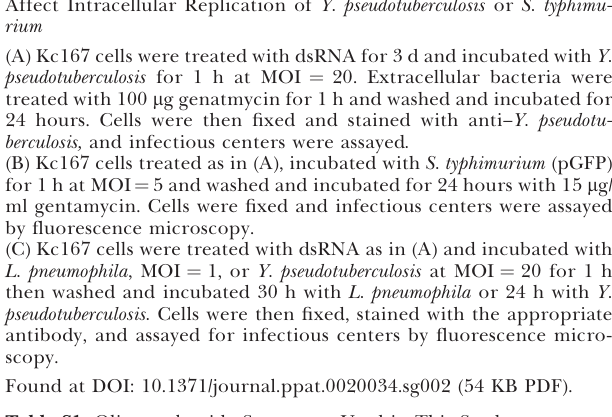
Figure S1. L. pneumophila Replicates Normally in Drosophila Kc167 Cells Kc167 cells were plated in 24-well dishes and incubated with Lp02 (intact type IV translocation system) or Lp03 ( dotA (cid:1) , defective for type IV translocation) at MOI ¼ 0.1 for 1 h; the monolayers were then washed and lysed, and bacterial counts were titred for colony- forming units at the indicated times. Each well was plated in duplicate and each timepoint represents triplicate wells. The mean is shown, 6 standard error. Figure S2. RNAi Directed against Cdc48/p97 and Cofactors Does Not Affect Intracellular Replication of Y. pseudotuberculosis or S. typhimu- rium (A) Kc167 cells were treated with dsRNA for 3 d and incubated with Y. pseudotuberculosis for 1 h at MOI ¼ 20. Extracellular bacteria were treated with 100 l g genatmycin for 1 h and washed and incubated for 24 hours. Cells were then fixed and stained with anti –Y. pseudotu- berculosis, and infectious centers were assayed . (B) Kc167 cells treated as in (A), incubated with S. typhimurium (pGFP) for 1 h at MOI ¼ 5 and washed and incubated for 24 hours with 15 l g/ ml gentamycin. Cells were fixed and infectious centers were assayed by fluorescence microscopy. (C) Kc167 cells were treated with dsRNA as in (A) and incubated with L. pneumophila , MOI ¼ 1, or Y. pseudotuberculosis at MOI ¼ 20 for 1 h then washed and incubated 30 h with L. pneumophila or 24 h with Y. pseudotuberculosis. Cells were then fixed, stained with the appropriate antibody, and assayed for infectious centers by fluorescence micro- scopy. Table S1. Oligonucleotide Sequences Used in This